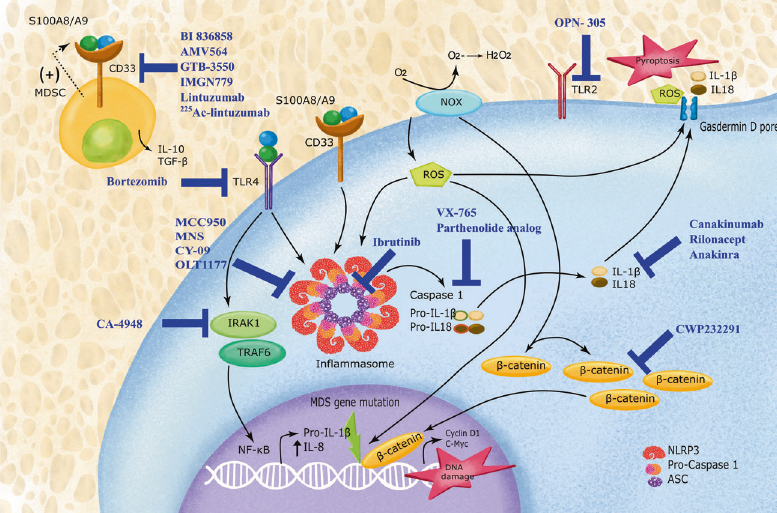
Fig. 3 Emerging therapeutic targets from the immune and in fl ammasome pathway in MDS. The fi gure depicts the various biomolecules from the in fl ammasome pathway that are targeted by the novel therapeutic agents in MDS and